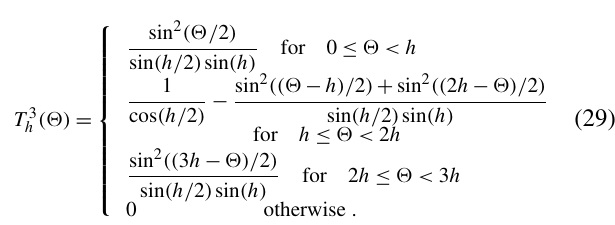
(ϕ) with shift value 3 , 9